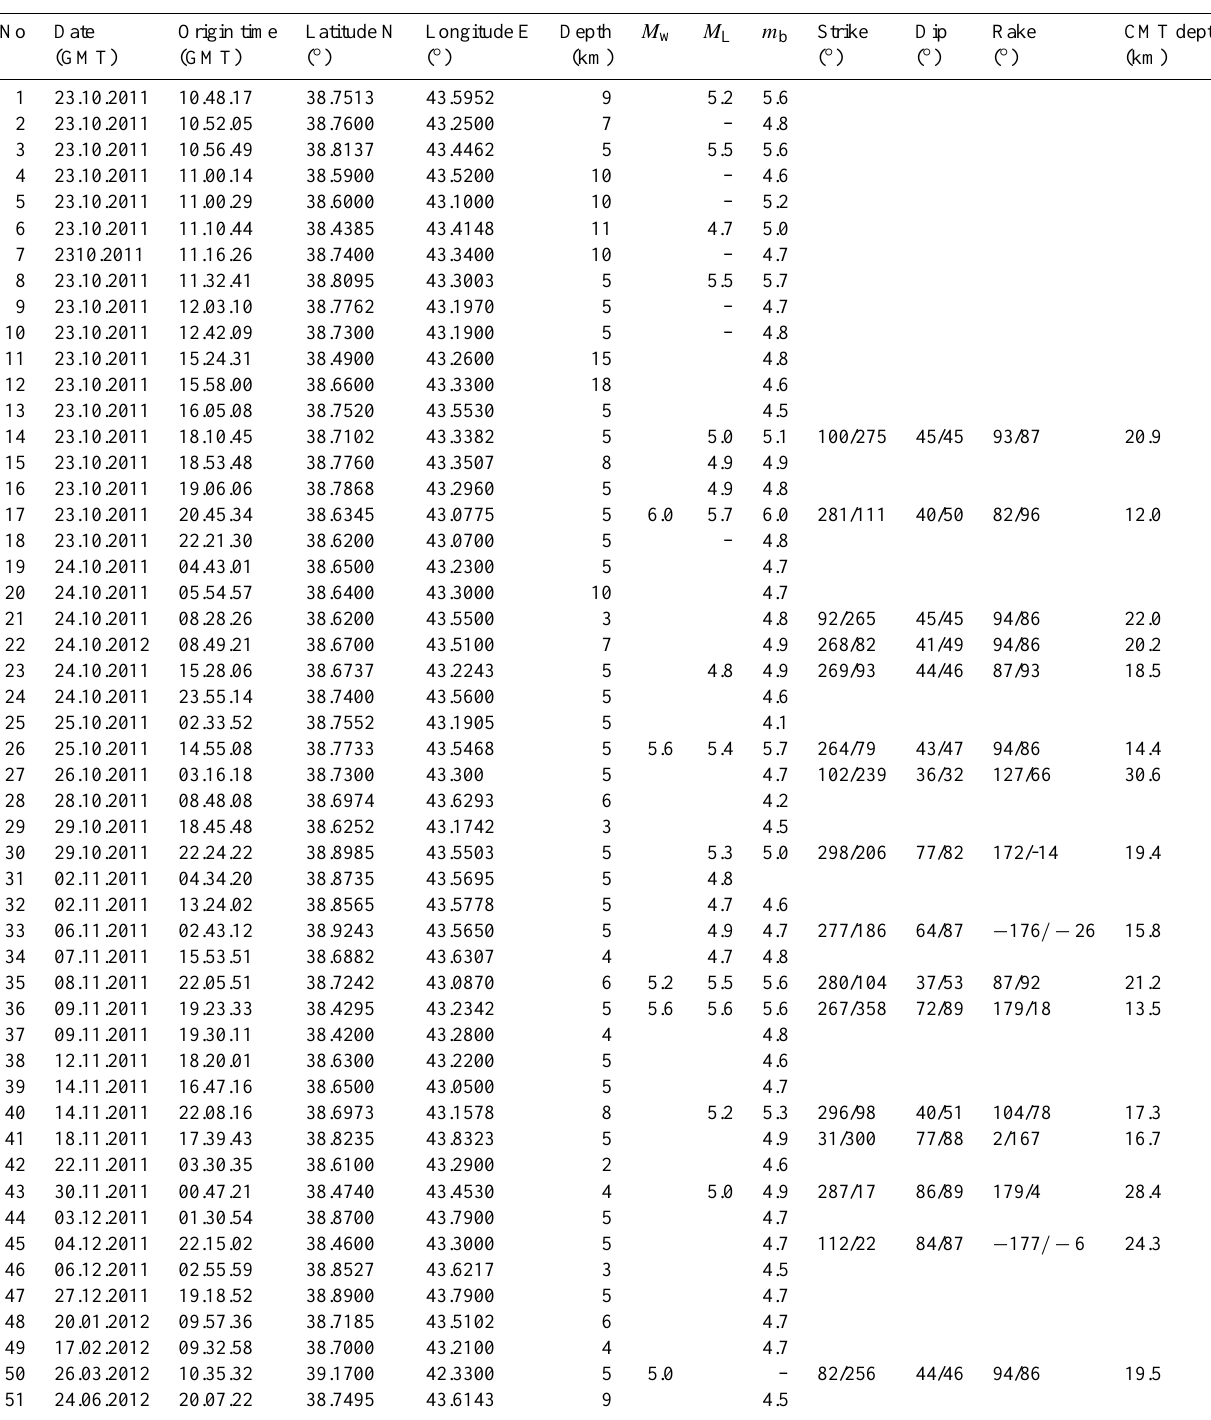
Table 3. The hypocentral and source parameters of the M ≥ 4.6 aftershocks of the 23 October 2011 Van earthquake, compiled from the catalogues of Kandilli Observatory and Earthquake Research Institute, GCMT and